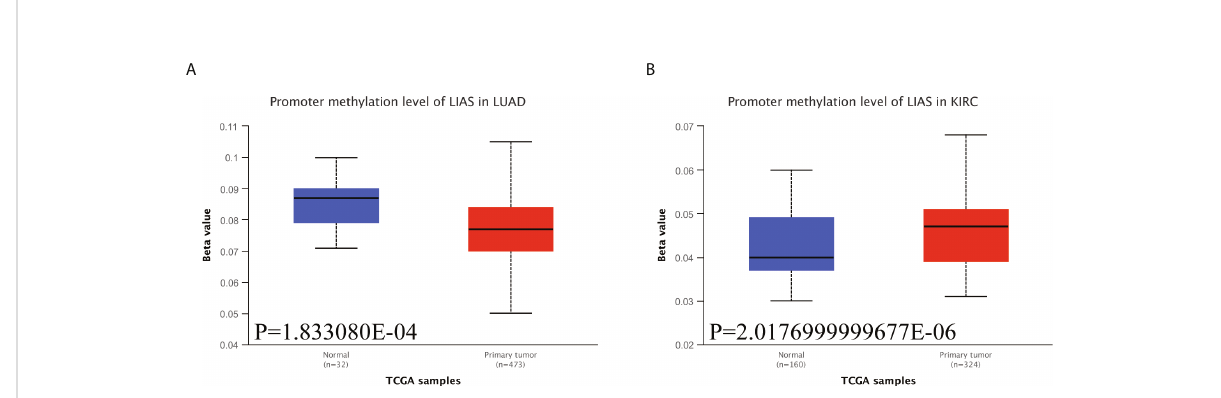
FIGURE 6 The methylation levels of LIAS in cancers. (A, B) The UALCAN database displayed the methylation levels of LIAS in patients with LUAD and KIRC,